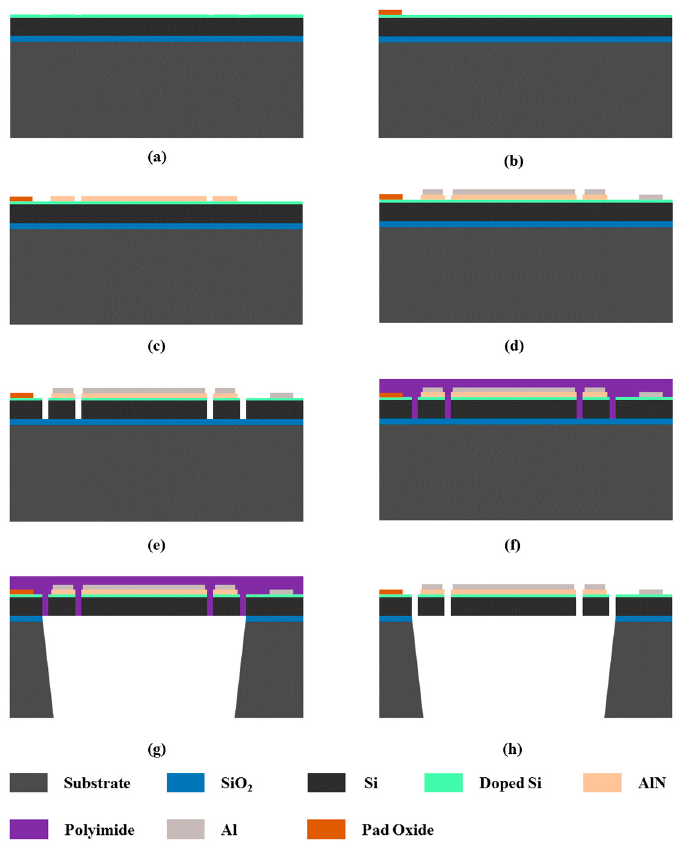
Figure 5. Detailed fabrication process. ( a ) Surface of the structure Si doped. ( b ) Pad oxide layer SiO 2 thermally grown and wet-etched. ( c ) AlN piezoelectric layer sputtered and patterned. ( d ) Al sputtered and patterned. ( e ) SOI wafer etched. ( f ) Polyimide deposited as a protective layer. ( g ) Backside etching. ( h ) Polyimide removed.